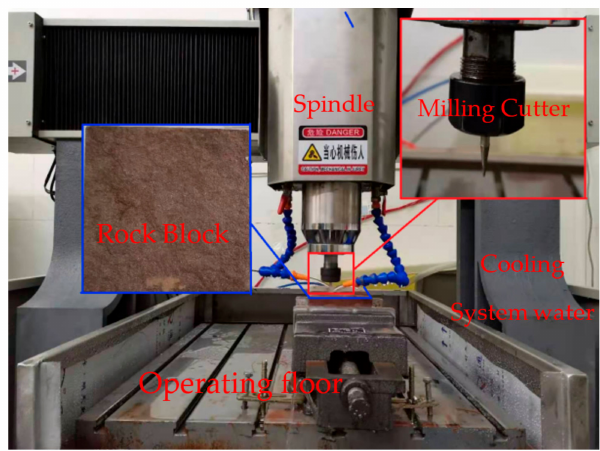
Figure 7. The MK-6060 rock engraving machine.